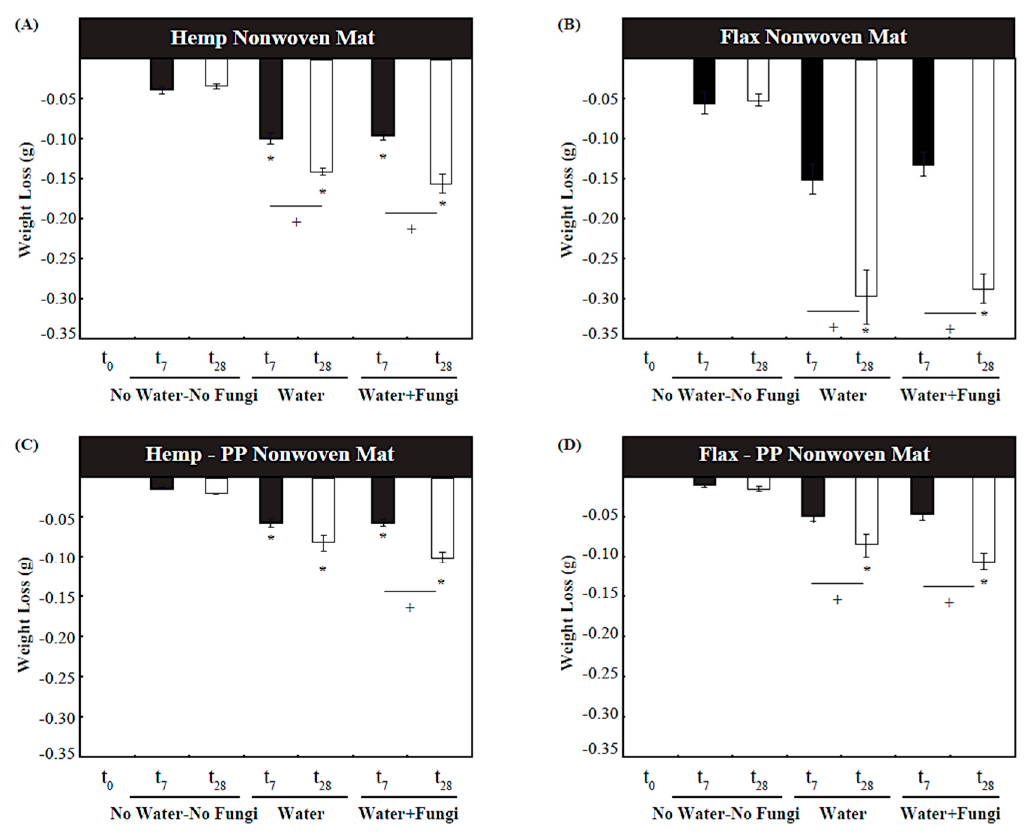
Figure 1. Weight loss testing for the four natural fiber mat types, each subjected to three different exposure conditions, measured at periods of 0, 7 and 28 days; the “ * ” sign indicates statistical significance (with a p -value < 0.05) compared to the control sample at t 0 (i.e., with no mass loss). The “ + ” signs indicate significate within the sample groups (i.e., the effect of exposure time). ( A ) Hemp Nonwoven Mat; ( B ) Flax Nonwoven Mat; ( C ) Hemp–PP Nonwoven Mat; ( D ) Flax-PP Nonwoven Mat.